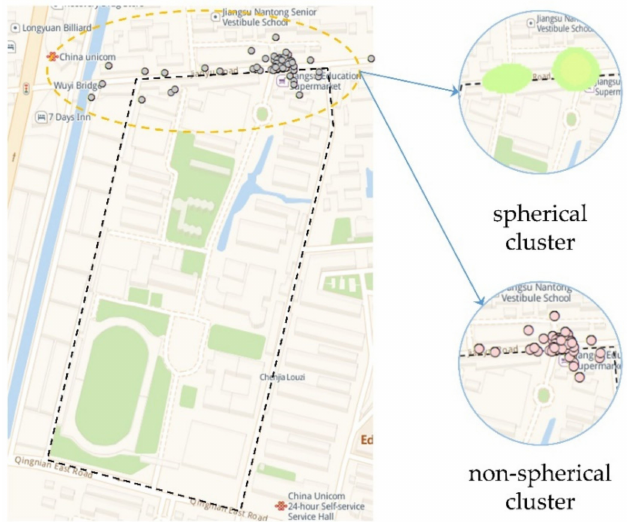
Figure 5. Clusters of different shapes discovered by DBSCAN and KDE